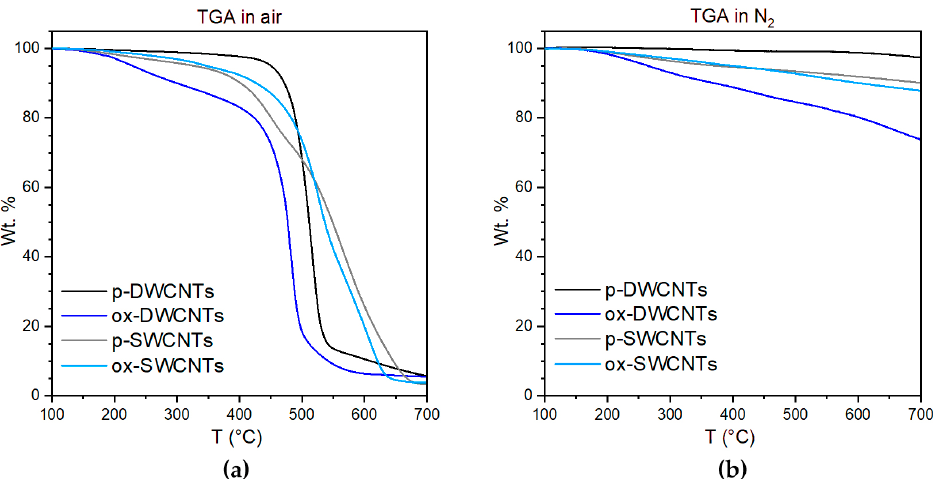
Figure 1. Thermogravimetric analysis (TGA) of pristine (p-) and oxidized (ox-) CNTs ( a ) in air and ( b ) in nitrogen. Visible near-infrared (Vis-NIR) absorbance was also assessed to characterize the CNTs. In particular, the NIR spectra of DWCNTs (Figure 2a) displayed a wide signal at 1425 nm that was ascribed to the outer walls’ first optical transition of semiconducting CNTs (E 11OUT ). The signals that were present between 1000 and 1370 nm were mainly associated with the corresponding transition of the inner walls of semiconducting